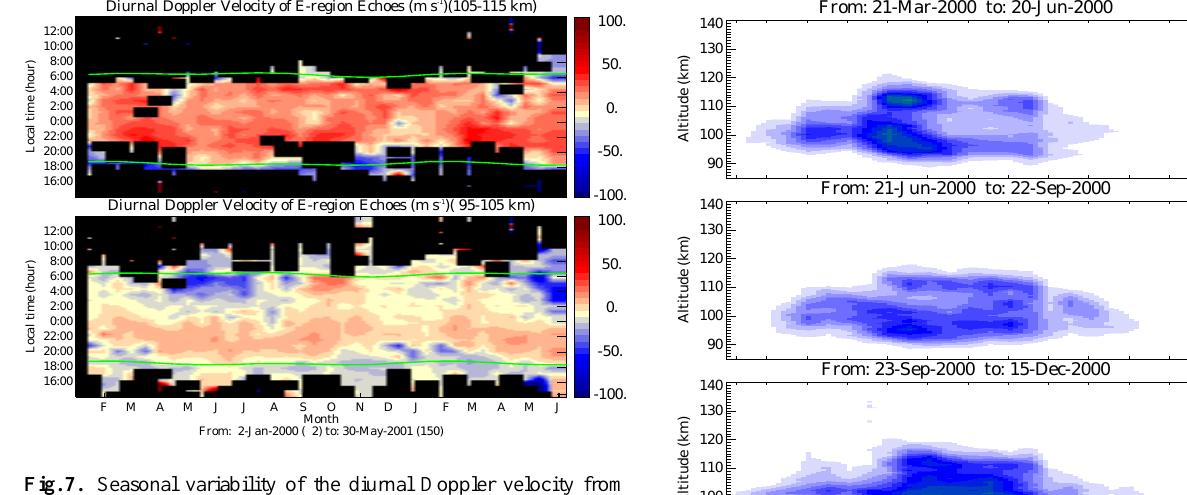
Fig.7. Seasonal variability of the diurnal Doppler velocity from lower E-region (bottom) and the upper E-region (top) irregularities. These statistics have been obtained by processing 15 days at the time. The local sunrise (sunset) times are shown with the upper (lower) green curve on each plot.